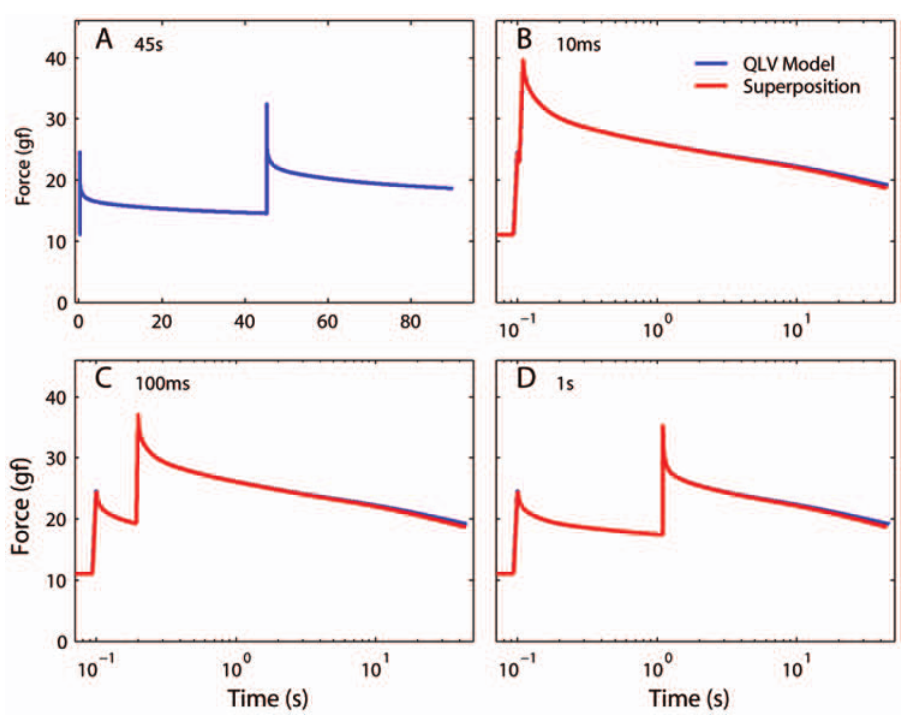
Figure 9. The QLV model obeys superposition. A : A sequence of two elongation steps (0.5 mm each), separated in time by 45 s, was simulated using the generalized QLV model, and the resulting force is plotted against time. B : The same two steps shown in A are applied, but now the temporal separation (ISI) is only 10 ms. (Blue: Model output. Red: Output expected if the superposition principle is obeyed. Note logarithmic scale for time.) C : Same as in B, but with an ISI of 100 ms. D : Same as in C, but with an ISI of 1 s. In all cases the model output matches the superposition prediction. The small deviation between the two traces toward the end of each simulation is due to the incomplete settling of the model output just before the second step in panel A (on which the superposition prediction is